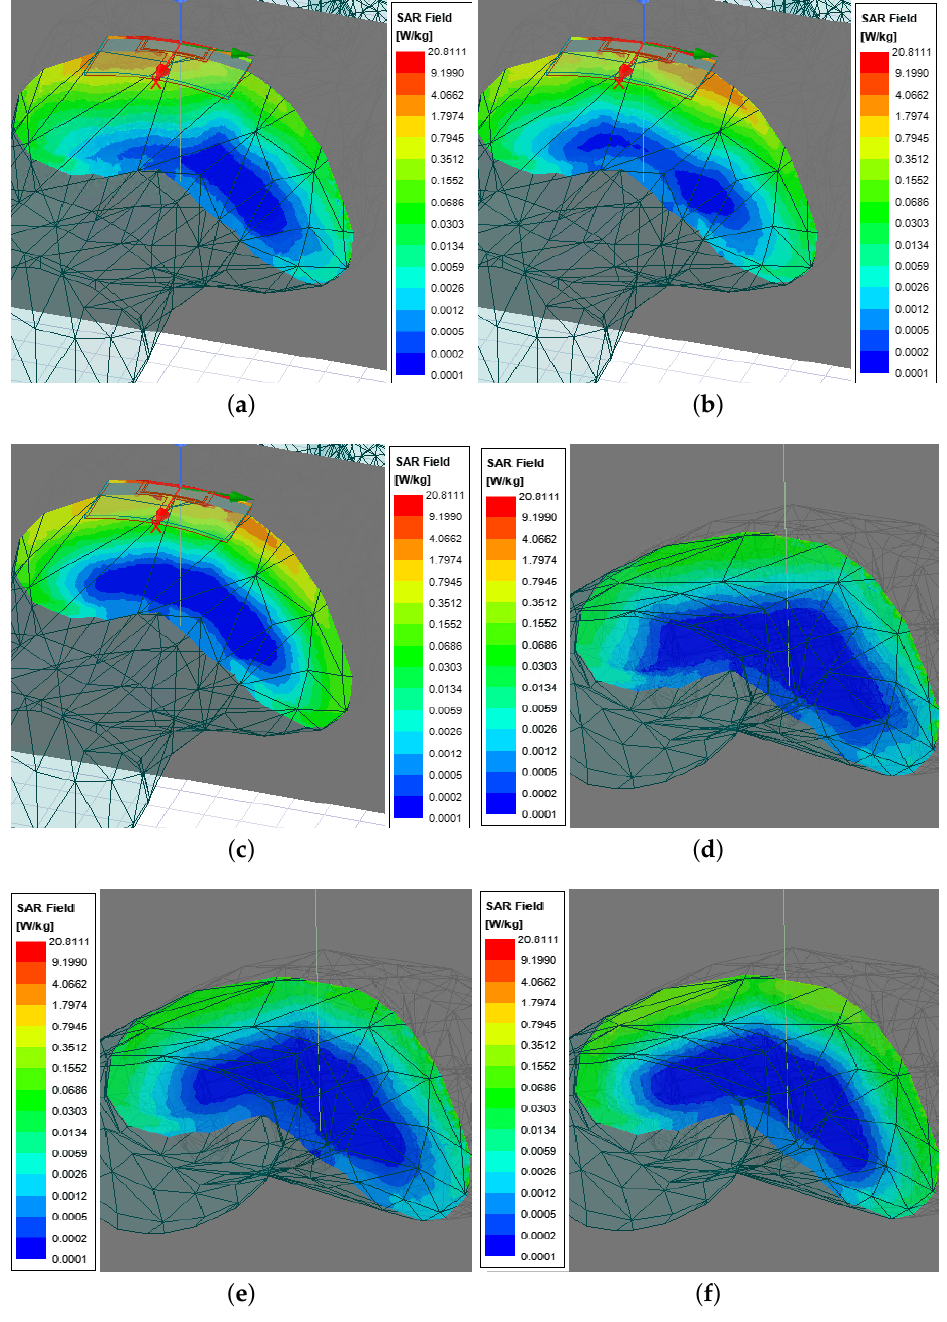
Figure 24. SAR avg plot on YoZ -plane. ( a ) 5.8 GHz for d ant = 0 mm; ( b ) 6.2 GHz for d ant = 0 mm; ( c ) 8.4 GHz for d ant = 0 mm; ( d ) 5.8 GHz for d ant = 40 mm; ( e ) 6.2 GHz for d ant = 40 mm; and ( f ) 8.4 GHz for d ant = 40